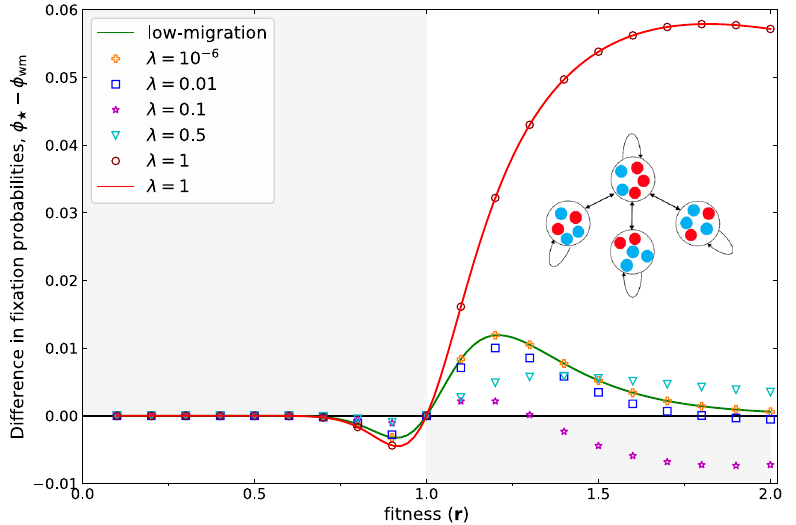
Figure 3. The difference between the fixation probability of a meta-star and the equivalent well-mixed population of size with M = 4 patches and identical local size in each patch N 1 = N / M = 5 for different fitness values. Lines show analytical results for low migration probabilities (Eq. 18) and migration probability (cid:31) = 1 (Eq. 19) symbols show numerical results based on a transition matrix approach 39 for (cid:31) = 10 − 6 , (cid:31) = 0.01 , (cid:31) = 0.1 , and (cid:31) = 0.5 . For migration probability (cid:31) = 10 − 6 , we observe an almost perfect agreement, the